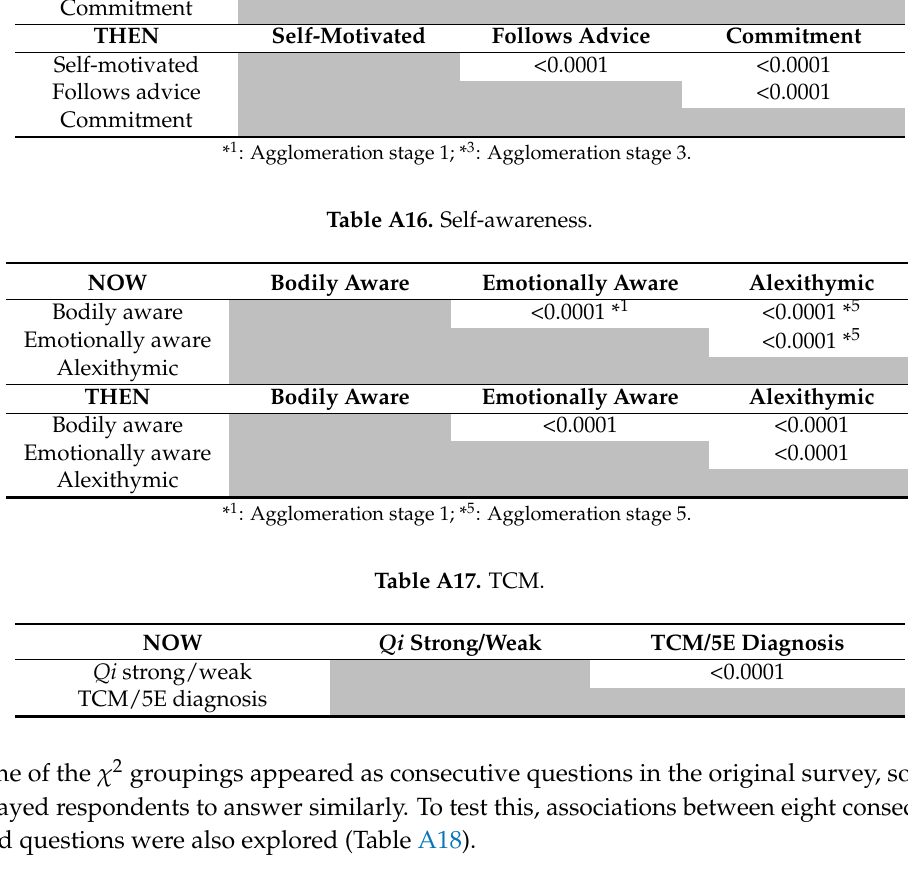
Table A18. Associations between consecutive survey questions from different groupings. Shown in bold are the χ 2 associations from Table